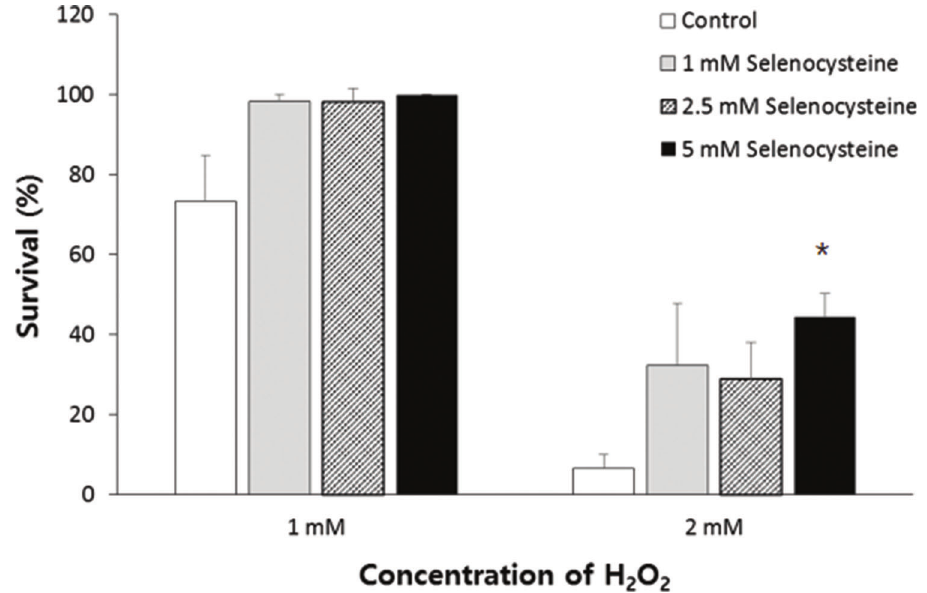
Figure 1 - Increased resistance to oxidative stress conferred by selenocysteine. Sixty age-synchronized young adult worms were pre- treated with different concentrations of selenocysteine for 24 h, then transferred to S-basal containing 1 or 2 mM H 2 O 2 to induce oxidative stress. After 6 h, the survival of worms was recoreded. Data indicate mean survival of three independent experiments. Asterisks indicate p -values less than 0.05 compared with the untreated